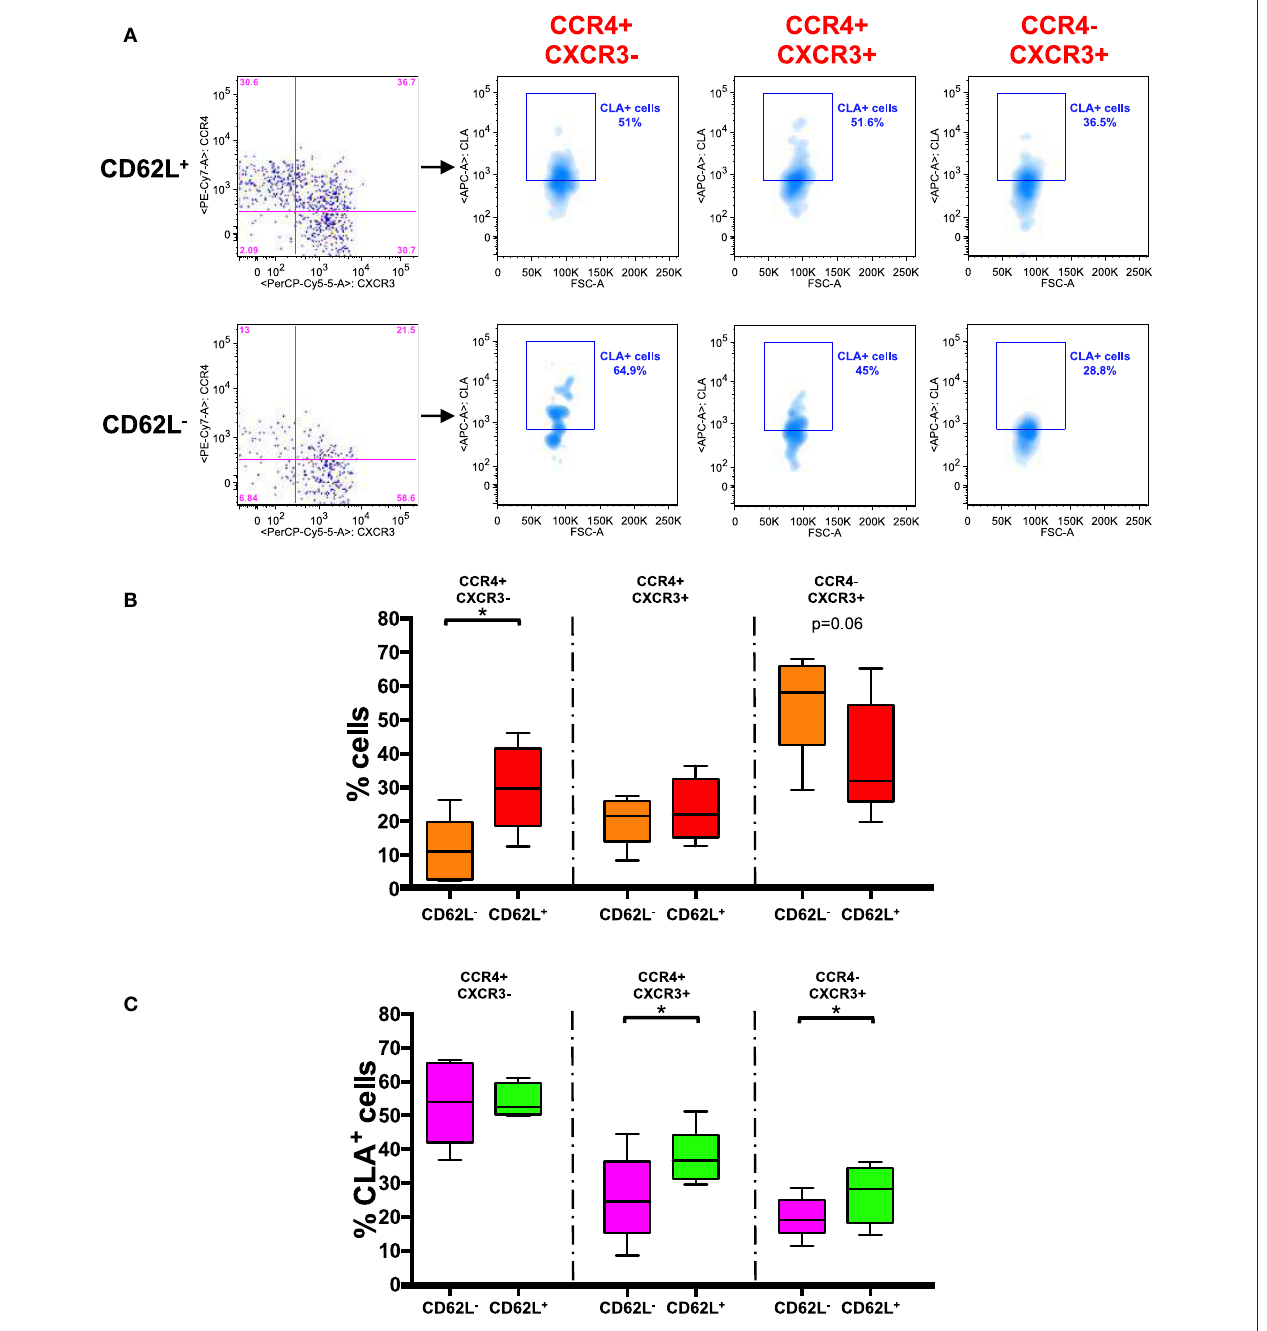
FIGURE 4 | CD62L + CCR7 + central memory T cells have a skin-tropic phenotype. (A) Representative analysis of chemokine receptor expression in CD62L + / − gated CD45RA − CCR7 + (T CM ) CD8 + T cells. Each subset (CCR4 + CXCR3 − , CCR4 + CXCR3 + , and CCR4 − CXCR3 + ) in CD62L + and CD62L − gates was also analyzed for the expression of CLA. The axis scales for fluorescence are reported as log and the axis scale for FSC is reported as linear. (B) CD45RA − CCR7 + (T CM ) CD8 + T cells were gated on the basis of the expression of CD62L and analyzed for the expression of chemokine receptors (CCR4/CXCR3). The percentage of positive cells for each phenotype in CD62L + and CD62L − gated cells was represented as Tukey’s boxplot. Significance of the differences was calculated using Student’s t -test for paired samples. p -values < 0.05 were considered significant: * p < 0.05. (C) CD45RA − CCR7 + (TCM) CD8 + T cells were gated on the basis of the expression of CD62L and further divided into different chemokine expressing subsets. The percentages of CLA + cells in the different subsets are represented as Tukey’s boxplot. Significance of the differences was calculated using Student’s t -test for paired samples. p -values < 0.05 were considered significant: * p < 0.05.